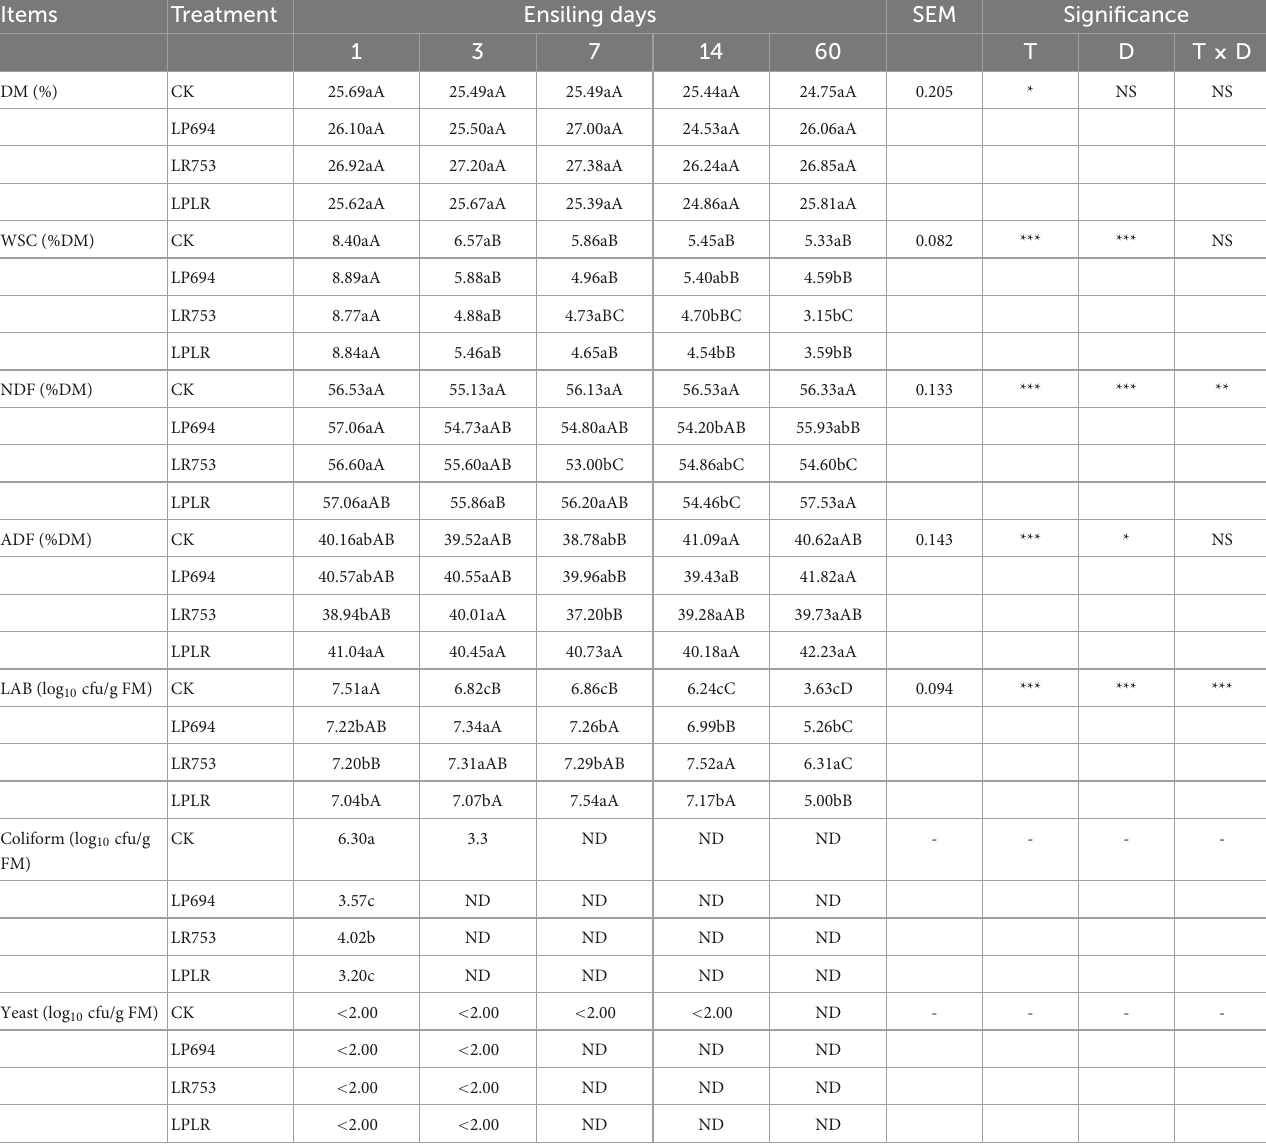
TABLE 3 Chemical characteristics and microbial counts of oat silages treated with or without lactic acid bacteria. Items Treatment